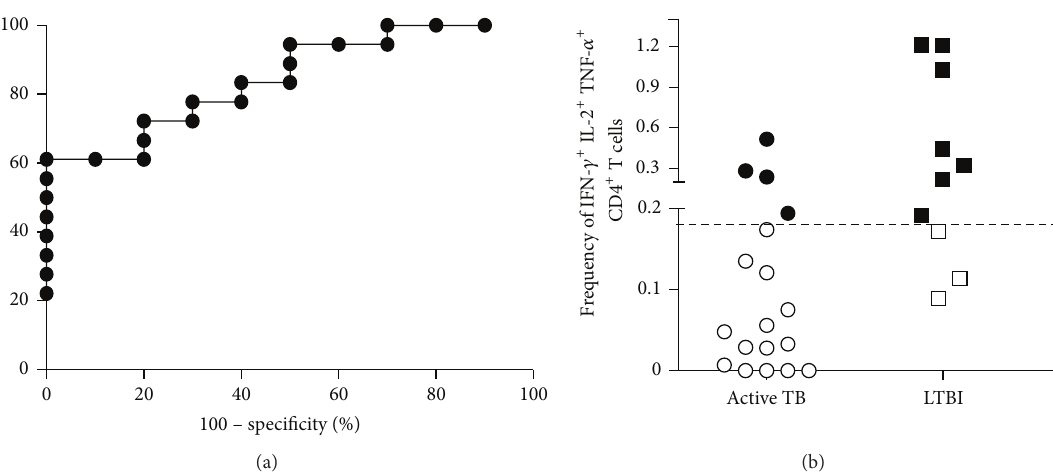
Figure 4: Differentiation between active and latent Mtb -infected subjects. (a) ROC curve (plotting sensitivity versus 1 − specificity) to discriminate active TB from LTBI patients. The area under curve (AUC) was 0.8444. (b) Analysis of triple-positive IFN- 𝛾 + IL-2 + TNF- 𝛼 + CD4 + T cells, using a cut-off to score responses as either positive or negative. The subjects were considered as positive (black) whether the frequency of CD4 + T cells was > 0.182% and negative (white) when the frequency was < 0.182%. Horizontal bars represent the median values and horizontal dashed line indicates the cut-off of 0.182%.